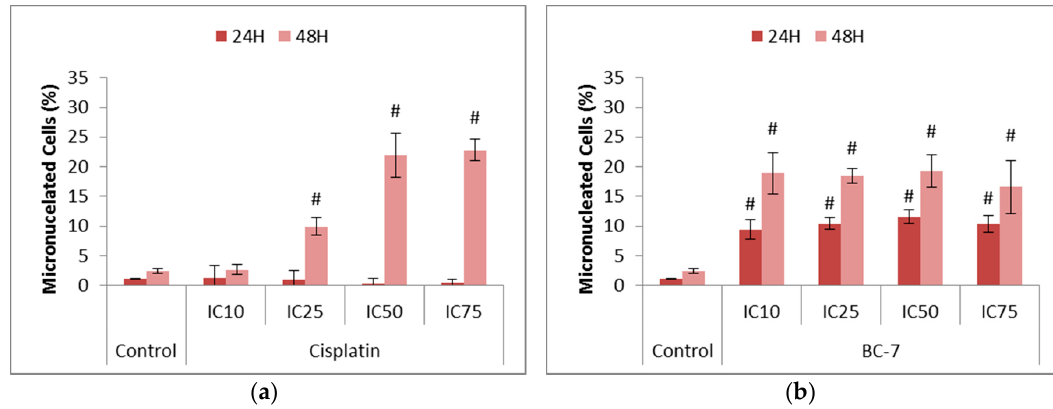
Figure 2. Assessment of micronuclei formation in HeLa cells after 24 and 48 h treatment with ( a ) cisplatin and ( b ) BC-7. The NucRed™ Live 647 staining method was used. Control treatment refers to untreated control. Results displayed as percentage micronucleated cells. Error bars indicate SD of three individual experiments, each performed in quadruplicate ( n = 3). Significance was determined using the two-tailed student t -test: # p < 0.005 compared to untreated control.